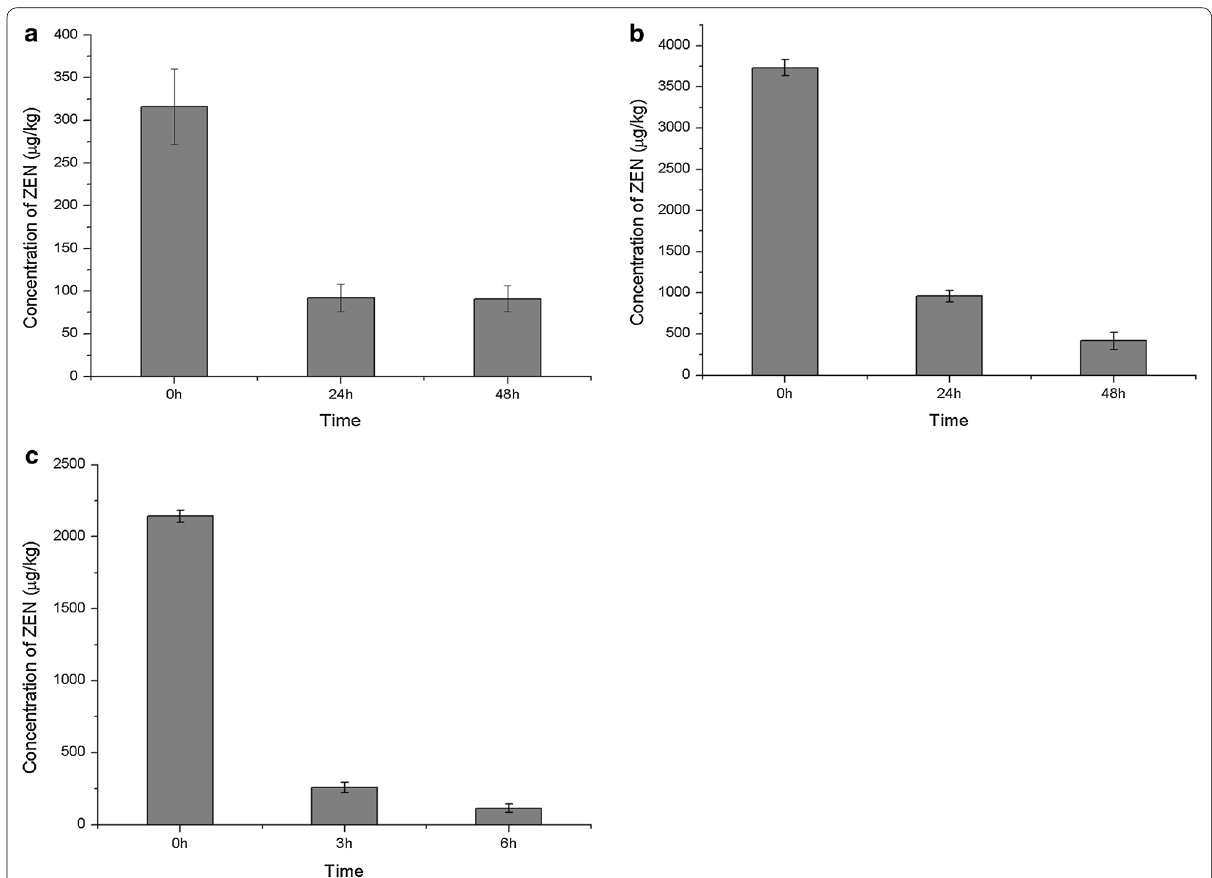
Fig. 4 Zearalenone (ZEN) degradation in different substrates on addition of ZENC. a ZEN degradation in DDGS. b ZEN degradation in maize by-products. c ZEN degradation in corn bran